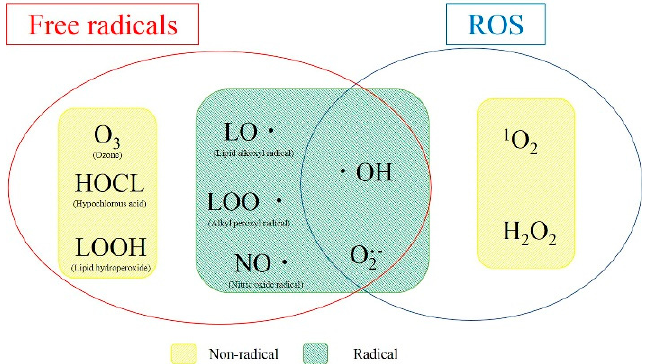
Figure 2. Diagram of radical and non-radical relationships in ROS and free radicals. Radicals are substances with unpaired electrons, and free radicals include non-radicals.